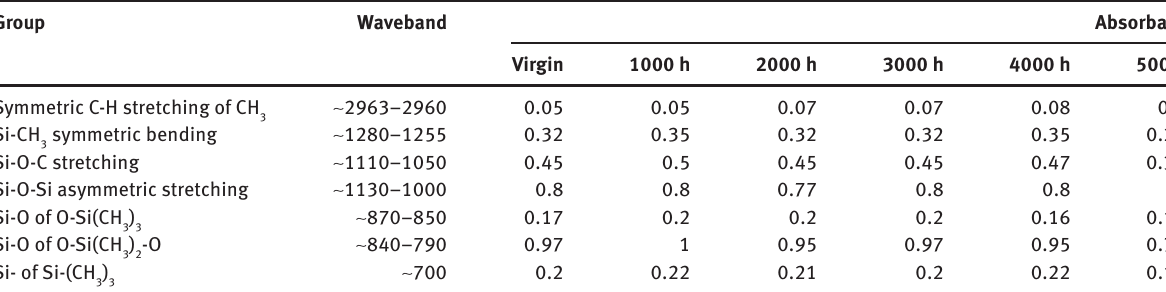
Table 5: Absorption peaks in SNC-2.5 from virgin to 5000 h. Group